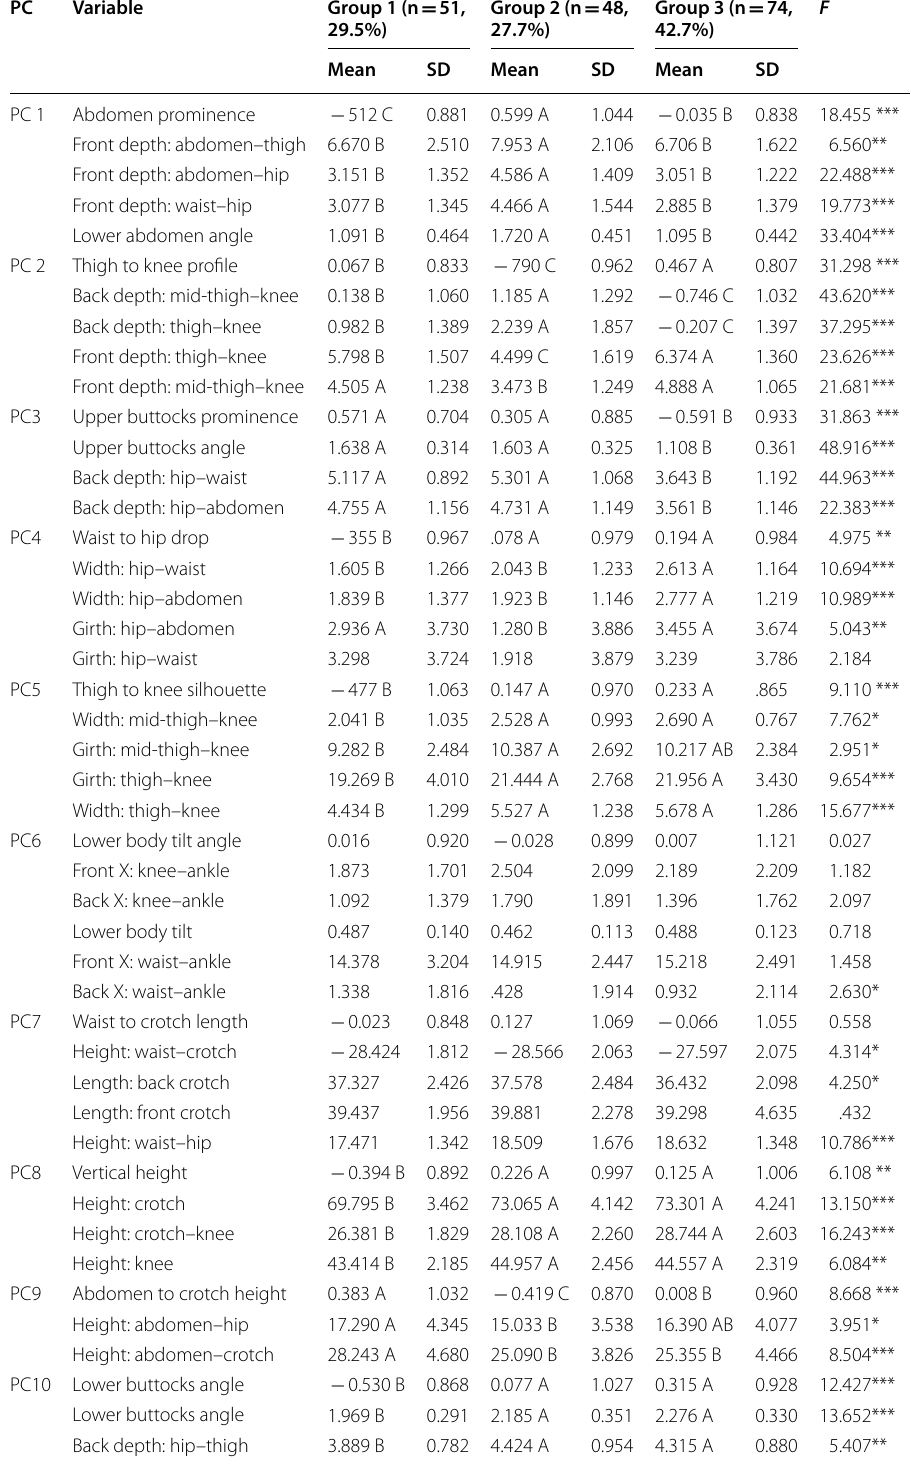
Table 3 Mean values of the three body shape groups and results of ANOVA for the 10 PCs and 35